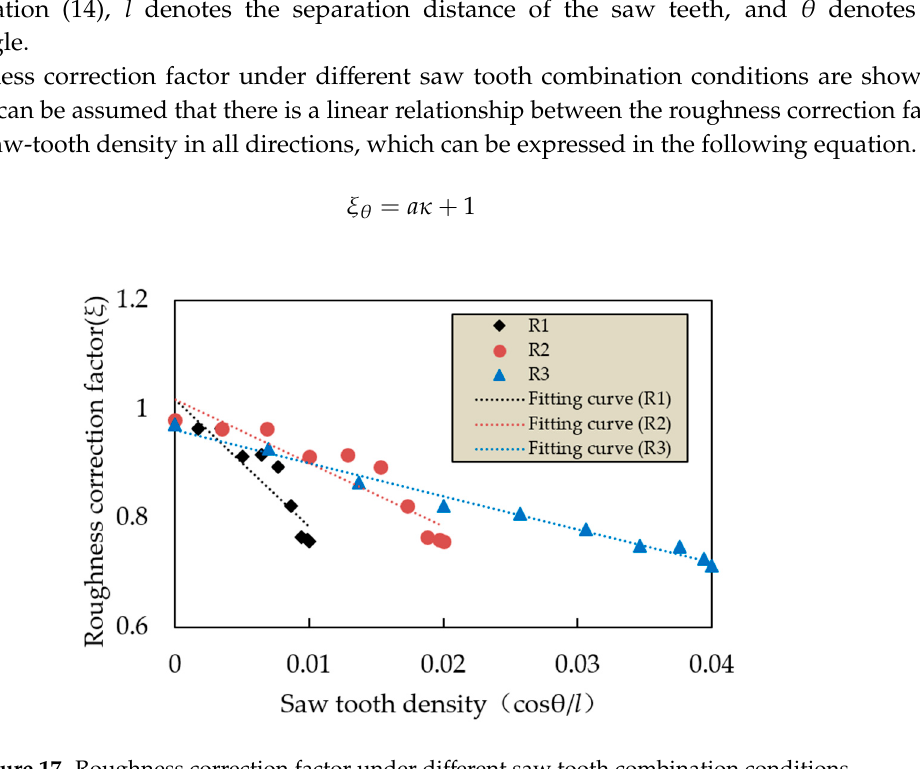
Figure 16. Equivalent openness in all directions under different test conditions.